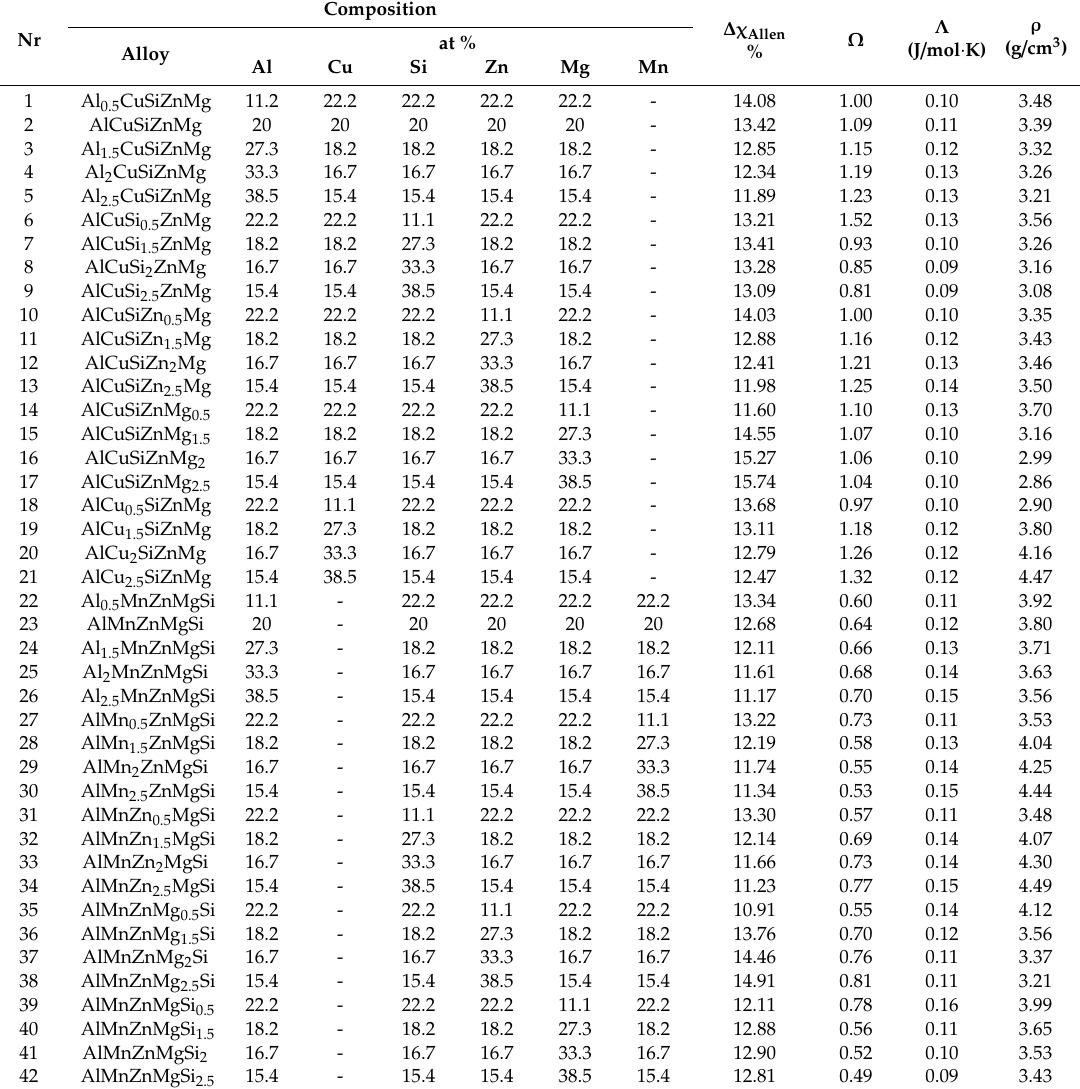
Table 1. Criteria calculation results for AlCuSiZnMg and AlMnZnMgSi